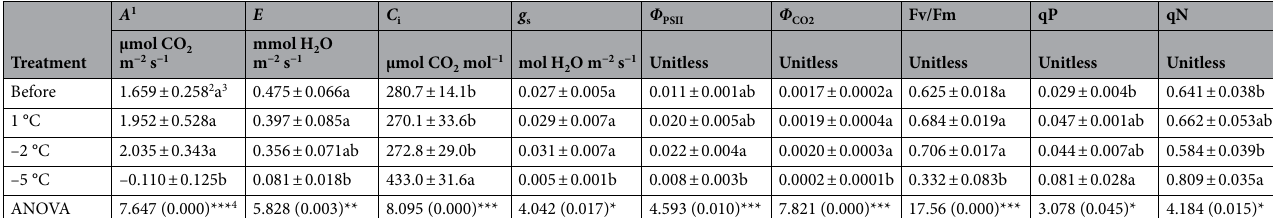
Table 2. Descriptive and inferential statistics of photosynthetic parameters at the operational points of the CO 2 (Fig. 2) and the light (Fig. 3) response curves. The means of biological replications are provided with the standard errors of the means in parentheses (n = 6). F-statistics of one-way ANOVA test results for low- temperature effect (df = 2) on these photosynthetic parameters are presented with statistical significance codes. The corresponding p -values of the F-statistics are presented in parentheses. 1 A , the net CO 2 assimilation rate; E , transpiration rate; C i , the intercellular CO 2 concentration; g s , stomatal conductance to H 2 O; Φ PSII , the quantum yield of photosystem II estimated by fluorescence measurement; Φ CO2 , the quantum yield of CO 2 assimilation estimated by gas exchange measurement; Fv/Fm, the maximum quantum efficiency of photosystem II reaction centers; qP, photochemical quenching; qN, non-photochemical quenching. 2 Means with ± 1 standard errors of the means from six replicates—three from A – C i and A - PPFD curves each under the ambient 400 ppm CO 2 and saturating light 1500 PPFD conditions. 3 Means within columns followed by different lowercase letters are significantly different according to Tukey’s honestly significant difference test at p < 0.05. 4 Statistical significance codes: *, **, and *** for p < 0.05, 0.001, and 0.001 levels,